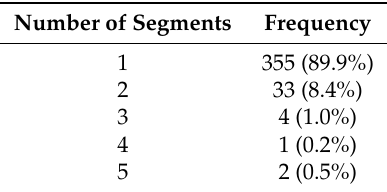
Table 6. The number of segments intersecting each tree canopy in the evaluation set, with respective frequency (relation to the total number of detected crowns, i.e., a total of